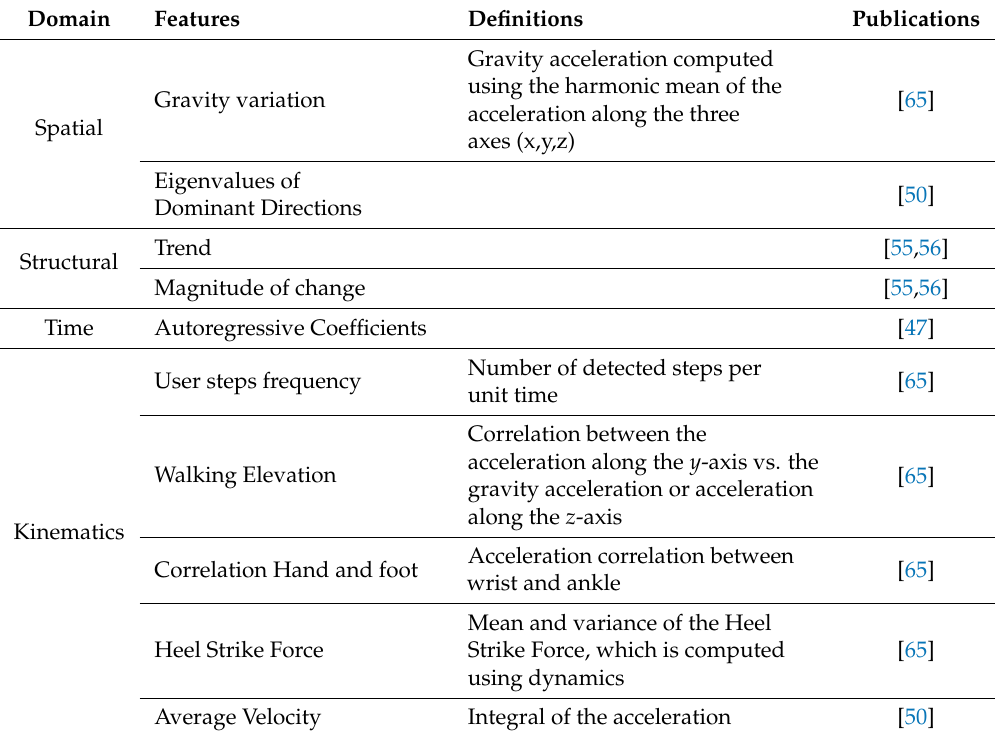
Table 12. Application-based features for